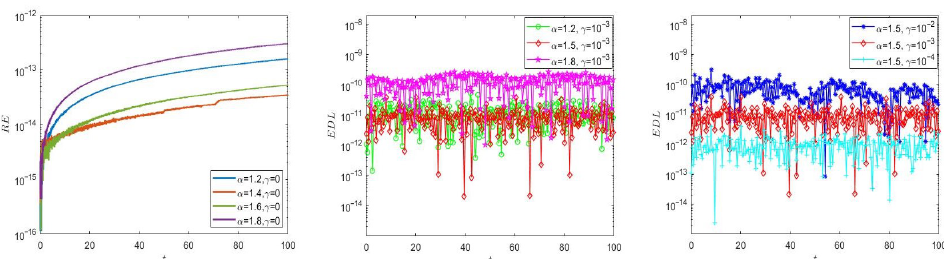
Figure 6. The relative energy errors RE n for γ = 0 and the errors in discrete dissipation-preserving law EDL n for different γ and α with h x = h y = 1/4 and τ =